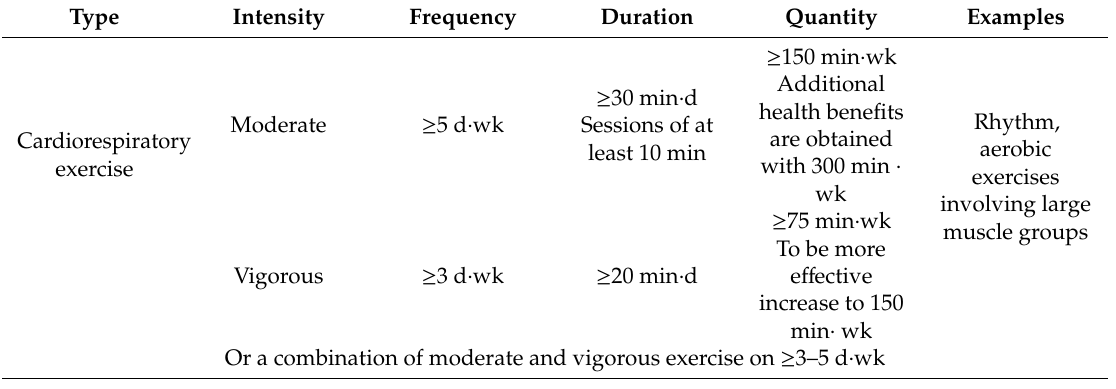
Table 1. Adapted from Physical Activity Guidelines